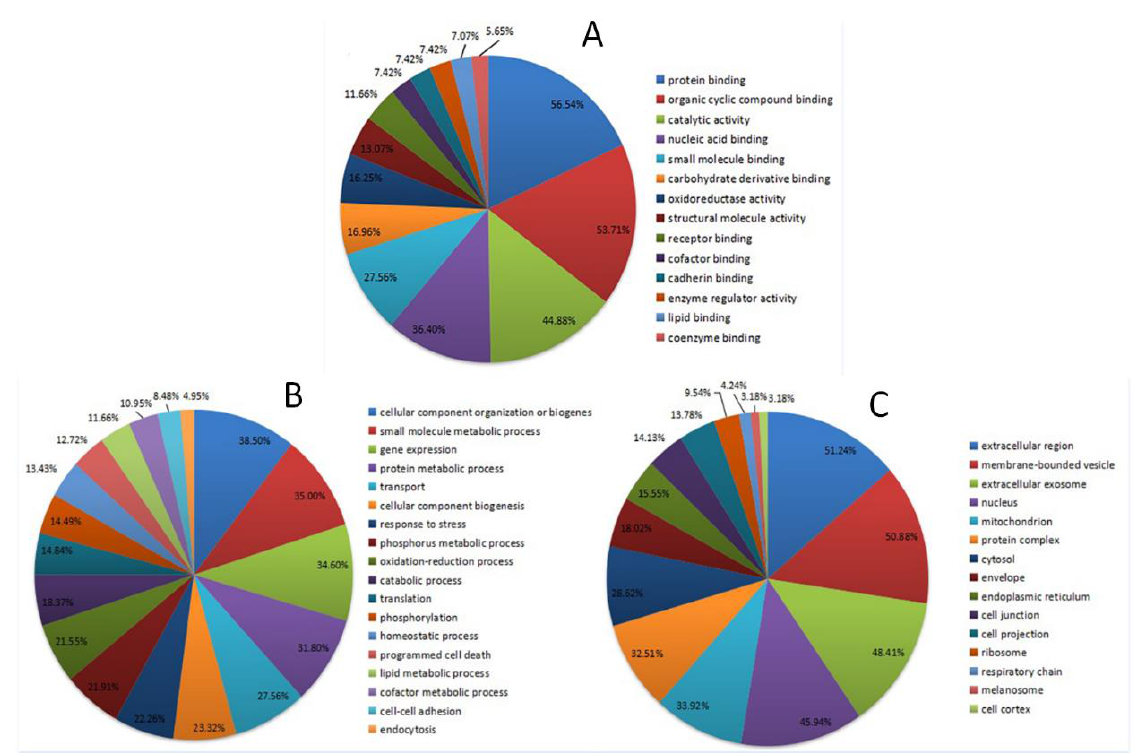
Figure 3. Results of GO analysis of differential proteins in HF group and HFB group. Molecular functions ( A ), biological processes ( B ), cellular functions ( C ).